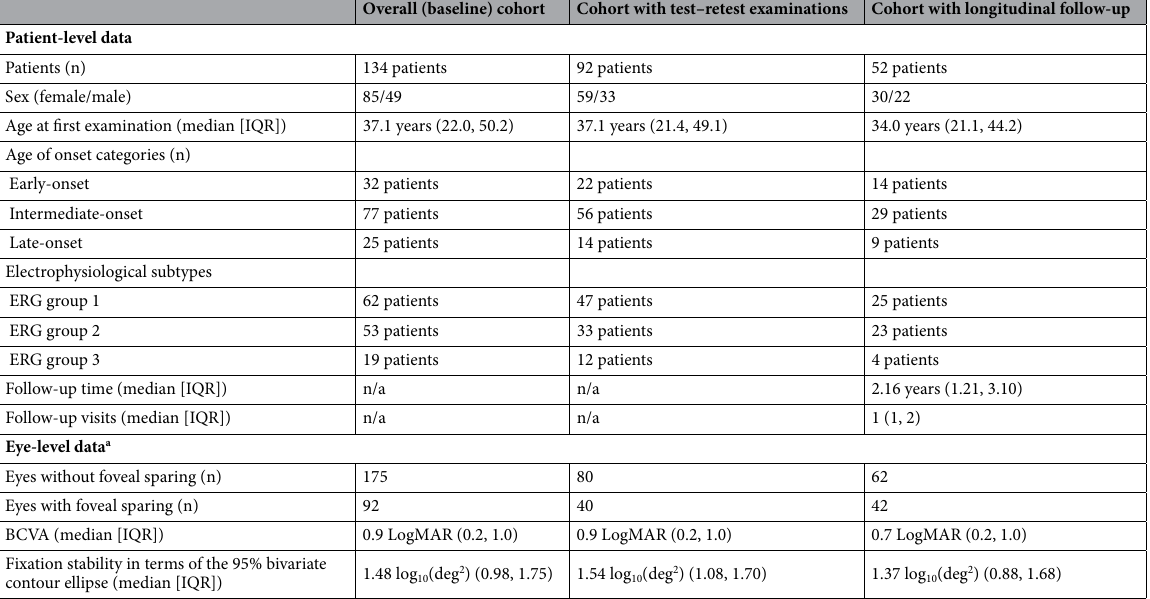
Table 1. Patient baseline characteristics. BCVA best-corrected visual acuity, ERG electroretinogram, IQR interquartile range. a One eye at baseline was excluded due to prior retinal